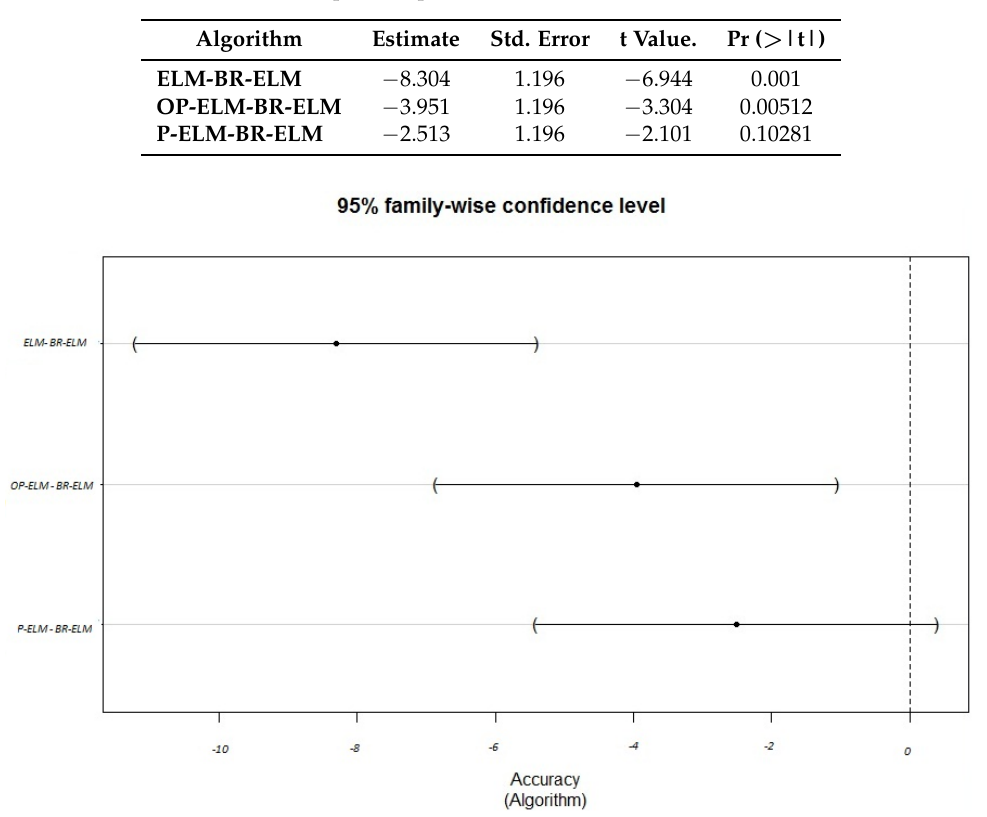
Figure 9. Dunnett